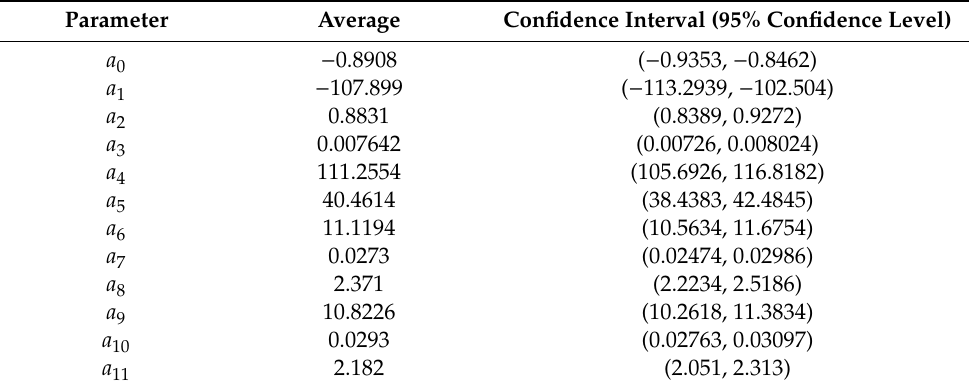
Table 1. Parameters of R ohm .